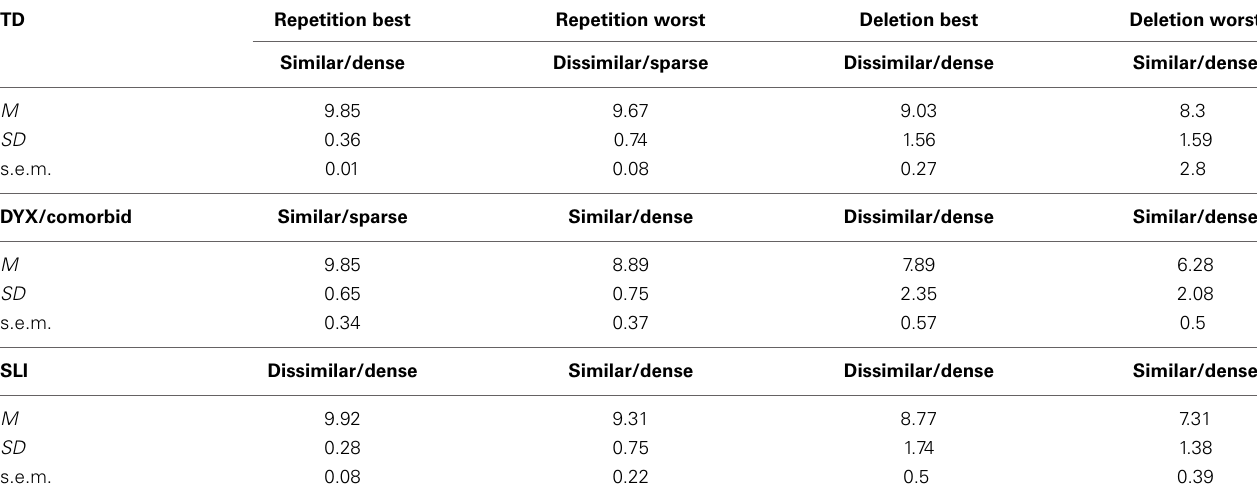
Table 4 | Qualitative differences in highest and lowest accuracy scores by group and task.